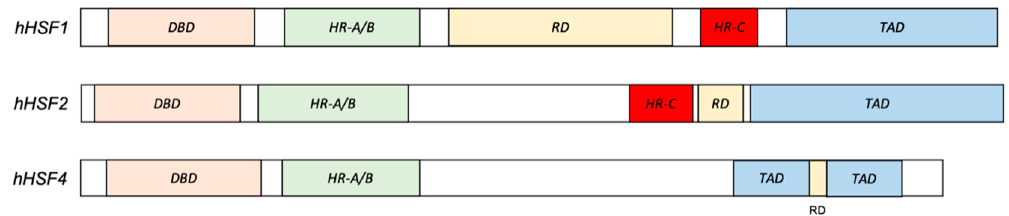
Figure 2. Comparison of human HSF1, HSF2, and HSF4 protein structure. All human HSF members possess a highly conserved DNA binding domain (DBD), oligomerization domain (HR-A/B), regulatory domain (RD), and the transactivation domain (TAD). In contrast to HSF1 and HSF2, HSF4 lacks the oligomerization repressor domain (HR-C).